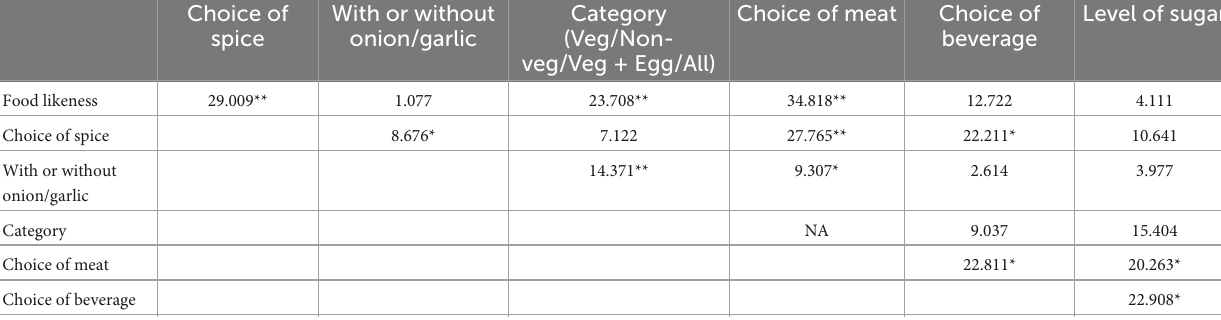
TABLE 4 Results of the normalised chi-square test for